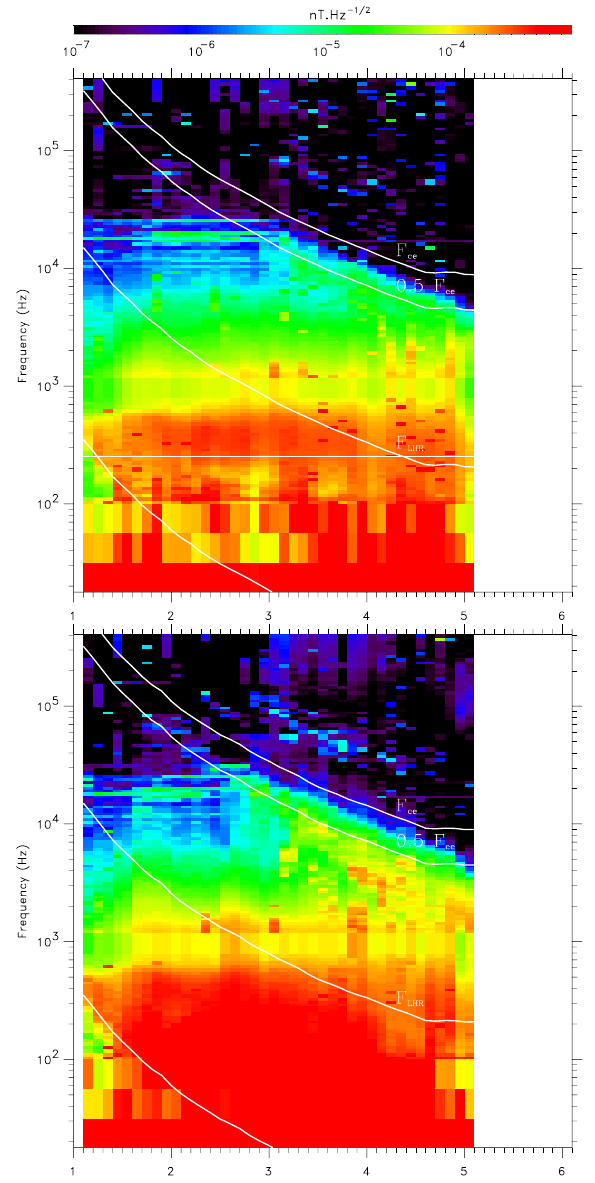
Fig. 5. Variation in L -values of the amplitude spectra averaged over Mlat values running from − 15 ◦ to + 15 ◦ . The lower panel cor- responds to spectra recorded during periods of weak geomagnetic activity and the bottom panel to spectra recorded during periods of strong geomagnetic